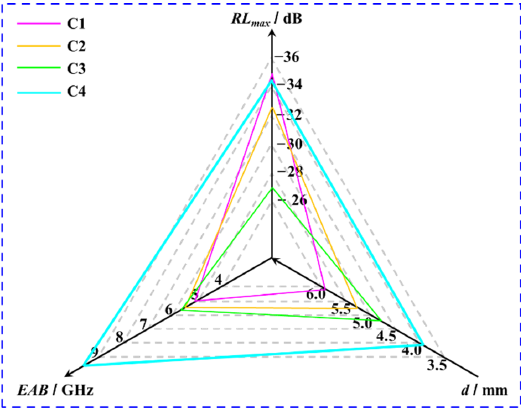
Figure 10. Comparison of electromagnetic wave absorption properties in C1–C4 composites.